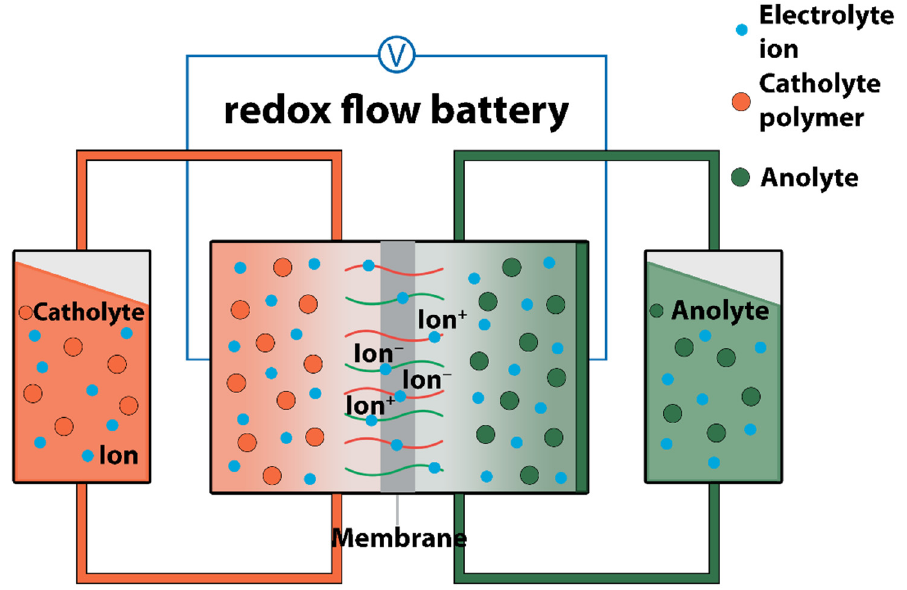
Figure 10. Schematic illustration of a polymer-based redox flow battery. The water-soluble copolymer of TEMPO methacrylate and choline methacrylate 119 as a catholyte was used with the methyl viologen anolyte and chloride-exchange mem- brane in all-organic aqueous redox flow cell [144]. The capacity of the catholyte comprises 8.3 Ah L − 1 . Introduction of the zwitterionic functionality instead of the cationic one signifi- cantly increases the solubility of the polymer and decreases the viscosity of the catholyte, affording catholyte 121 with volumetric capacity as high as 20 Ah L − 1 [145]. In 2015, Janoschka et al. reported an aqueous all-polymer redox flow battery with a water-soluble copolymer of TEMPO methacrylate and choline methacrylate 120 as a catholyte material, a viologen-containing cationic polymer as an anolyte material and cellu- lose membrane [146]. The capacity of the TEMPO-polymeric catholyte reached the value of 10 Ah L − 1 and the devices were functional at current densities of up to 40 mA cm − 2 . The authors also demonstrated that the nature and fraction of the solubilizing comonomer in the polymer has a dramatic influence on its solubility in water and rheological characteristics, which directly determine the energy and power density of the cell [147].